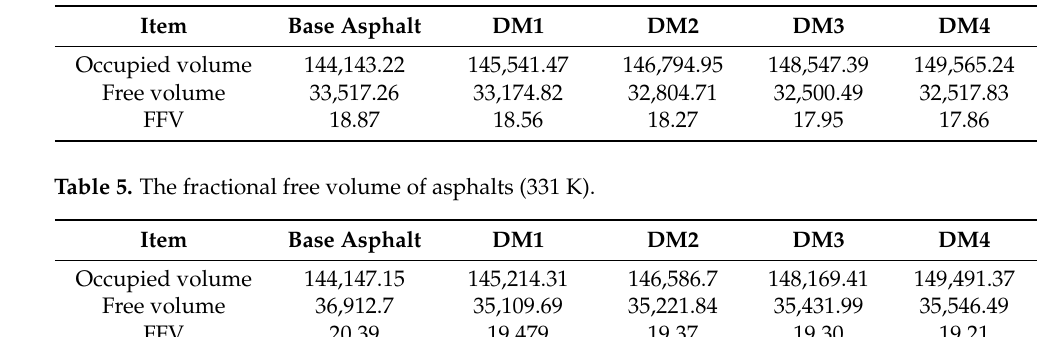
Table 4. The fractional free volume of asphalts (298 K).